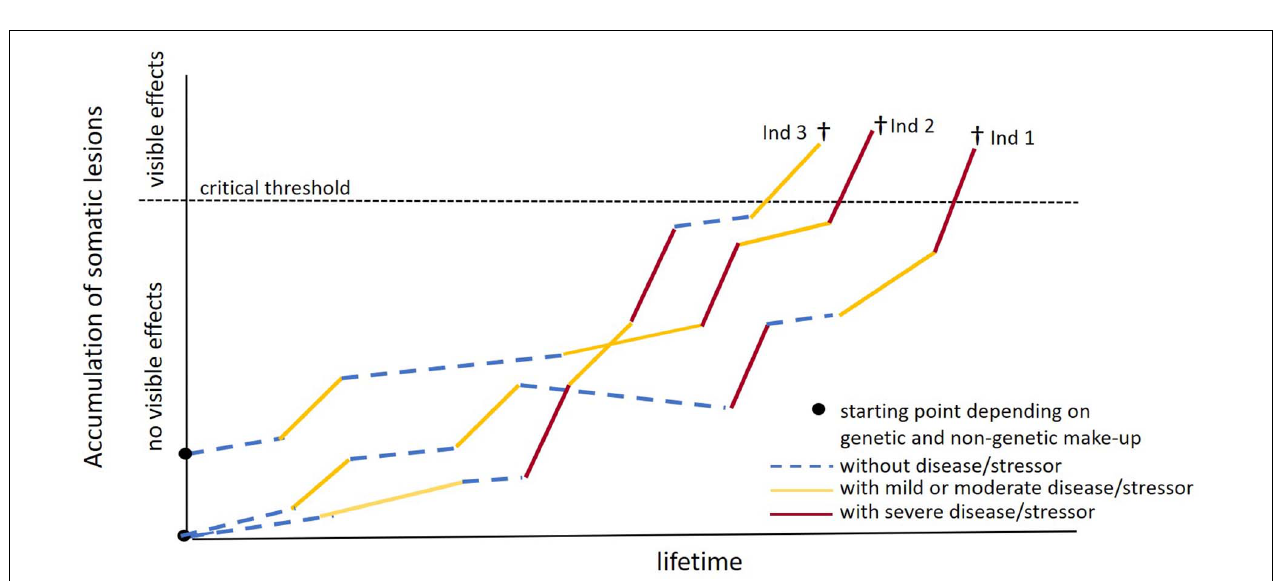
FIGURE 2 | Hypothetical example of accumulation of somatic lesions up to a critical threshold (the “critical point”) when (previously hidden) costs become “visible,” as envisioned by the accumulating costs hypothesis . With low effects of diseases and stressors, lesions accumulate slowly over time (blue dashed line). With increasing severity of diseases/stressors (yellow, orange and dark red solid lines) lesions accumulate more rapidly. Note that even though individuals can have different starting points (individual 2 and 3), which may affect their capacity to absorb lesions without any visible effects, individual 2 (with a “better” starting point in early life) may accumulate lesions at a higher rate during adult life and in fact cross-over the trajectory of individual 3 and thus experience a shorter life span due to differences in the magnitudes and frequencies of stress episodes these individuals experience during adult life. Note also that cellular repair mechanisms